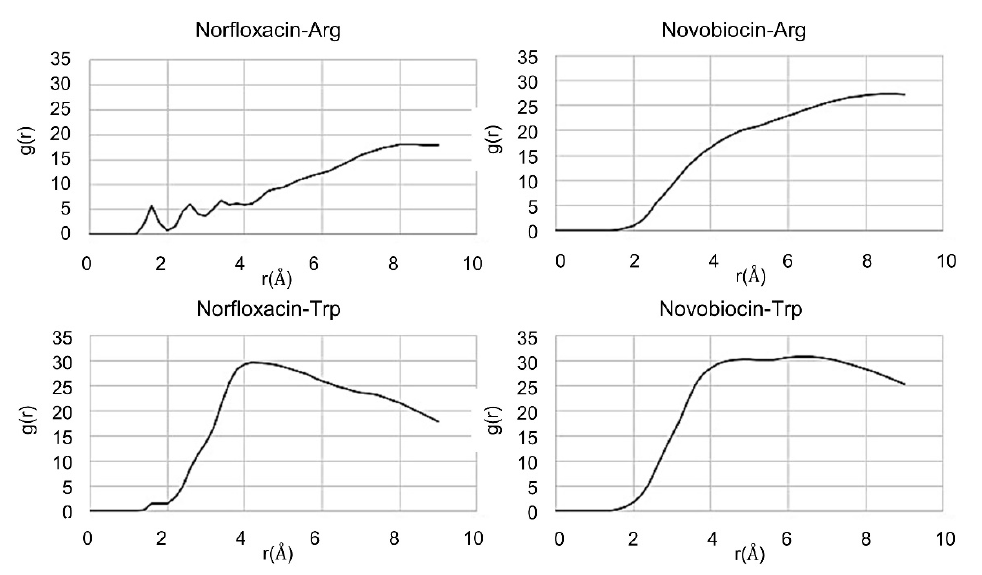
Figure 7. Plots representing the radial distribution function (RDF) patterns obtained from the trajectory of 50 ns MD simulation of a system containing peptide 6 (WRWRW-NH 2 ) and either novobiocin or norfloxacin.